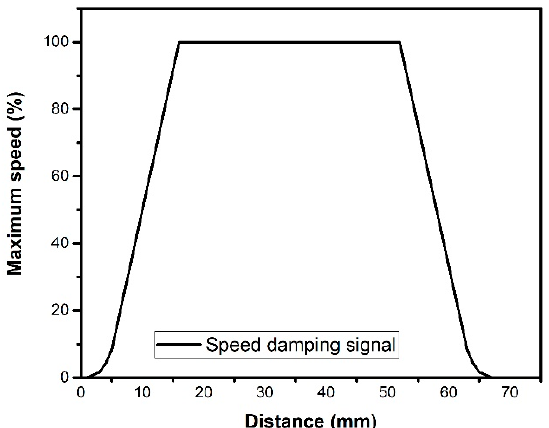
Figure 10. Percentage of maximum speed of the moving platform considering the distance of 67 mm.